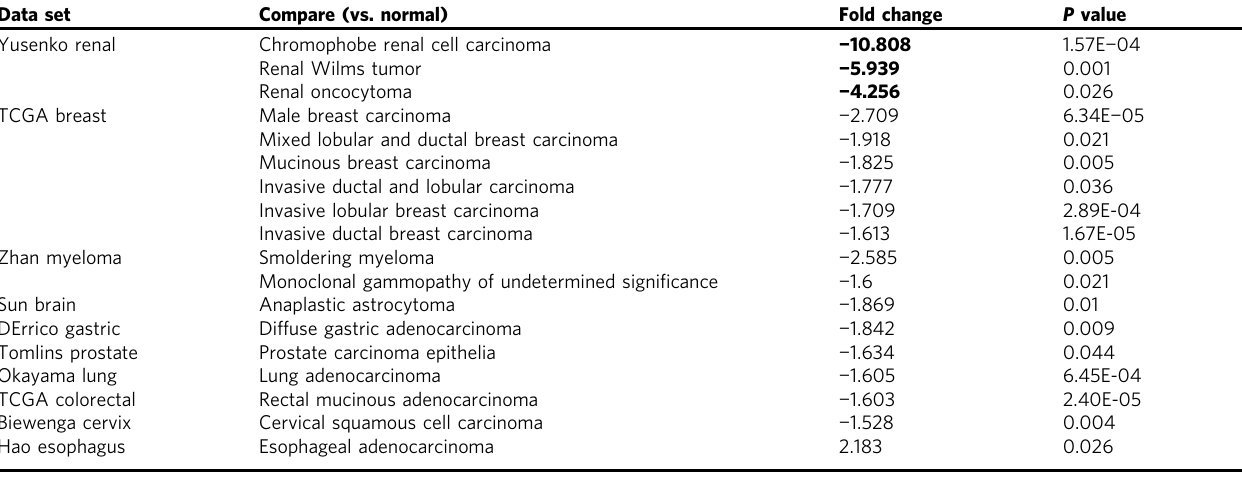
Table 1 The expression of FILNC1 in different types of human cancers. Data set Compare (vs. normal) Fold